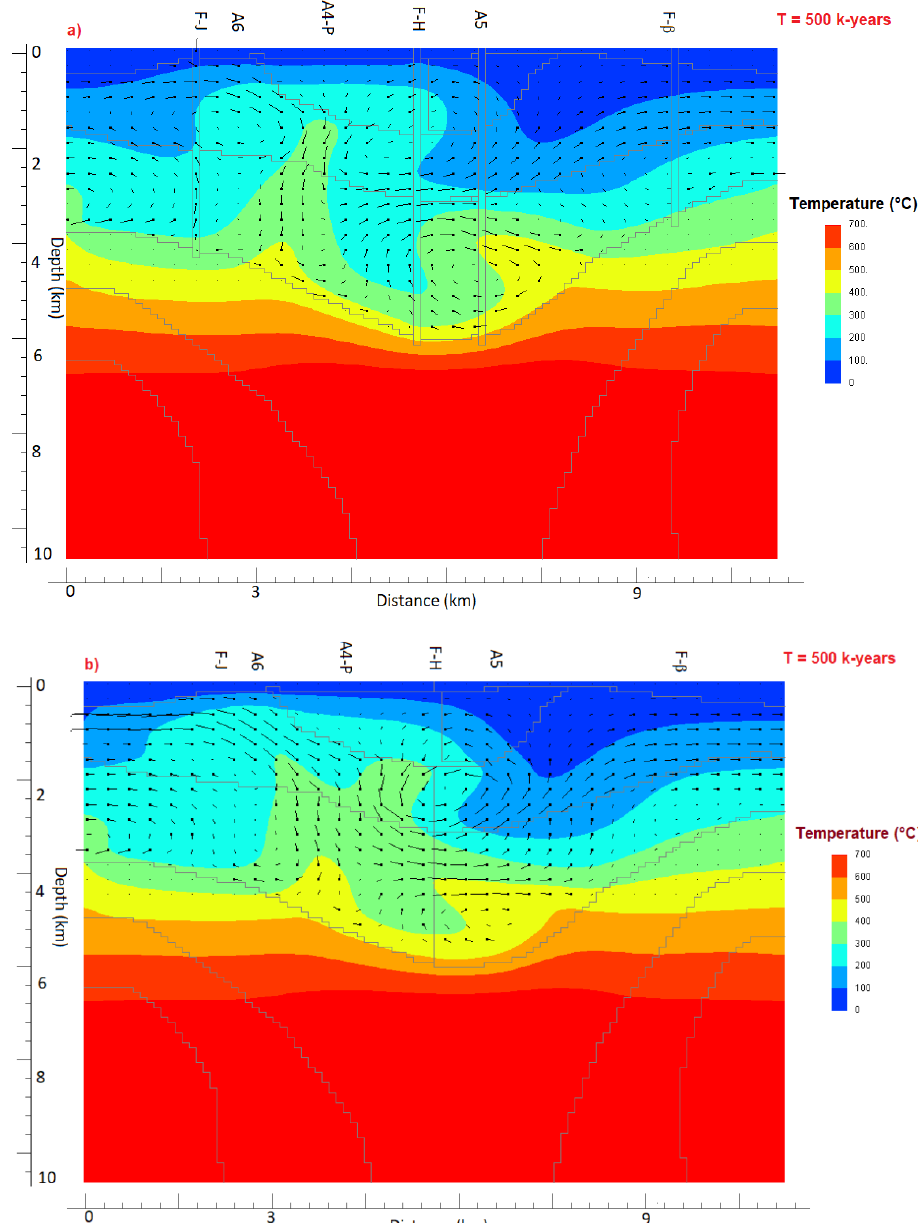
Figure 6. Simulated temperature and flow vectors at time 500,000 years for ( a ) scenario 5B and ( b ) scenario 6B. The direction of flow is from the point to the end of straight lines. The length of each line indicates the water vector magnitude, where 1.2 km = 10 −6 g s −1 cm −2 . Fluid circulation in scenarios 7 and 8 (Figure 7) present common features and similarities. In scenario 7, the hot upflow area is concentrated in the 300 – 400 °C isotherms, and part of the fluid is discharged at the surface close to faults H and F (F-H and F-F), whereas in the other parts of the rift, fluid is flowing laterally and directed toward the northeast and southwest before recirculation with vertical downflow that takes place at depth. Additionally, the high temperature gradient at the center allows the formation of